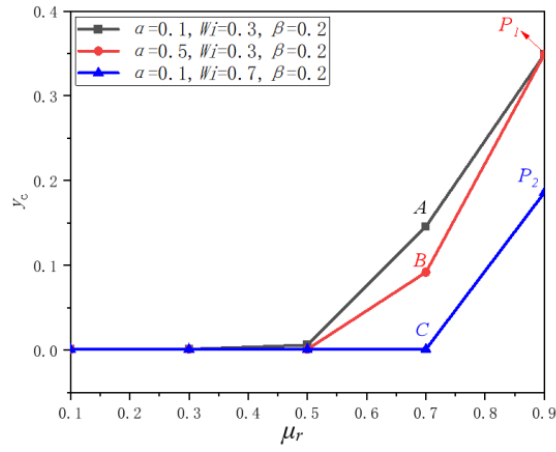
Figure 4. y c as a function of µ r for different values of α and Wi ( β = 0.2).